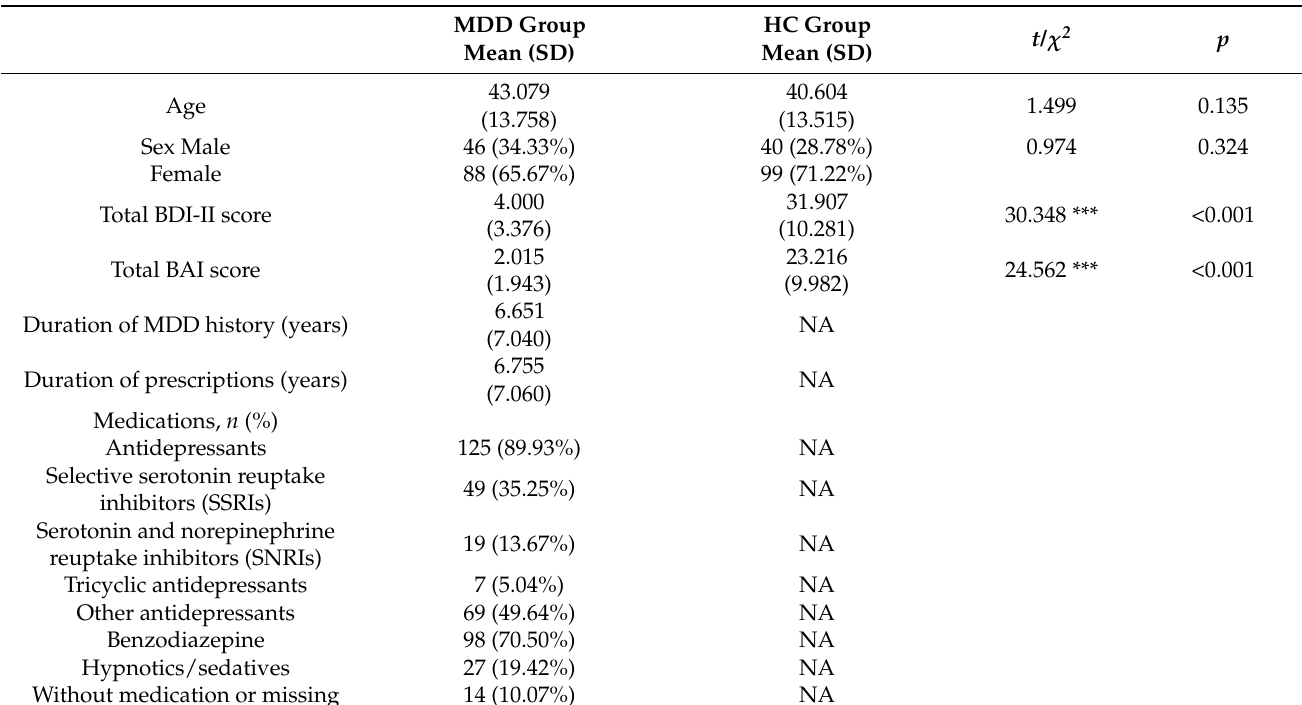
Table 1. Demographic data, BDI-II and BAI scores, and medications for MDD ( n = 139) and HC ( n = 134)